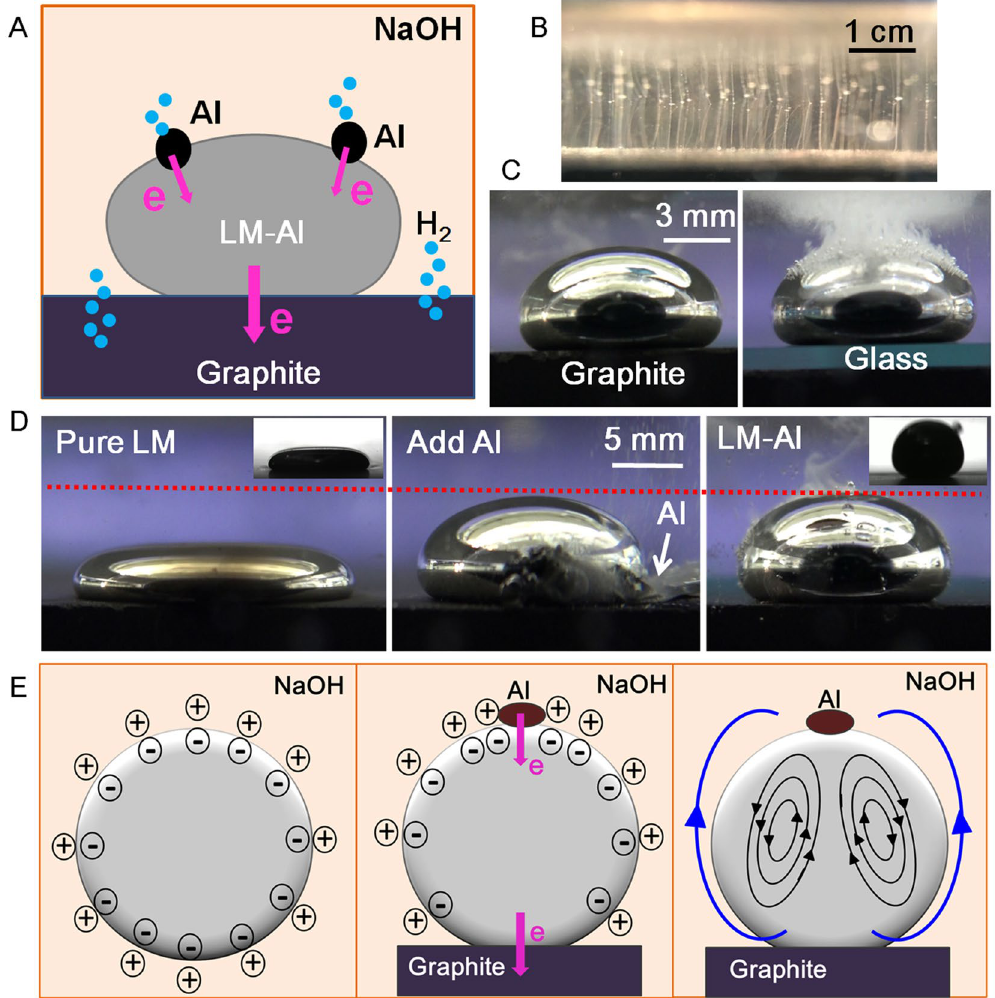
Figure 2. ( A ) Schematic diagram of the electrochemical interactions among Al, LM and graphite. ( B ) Hydrogen was bubbling from the gap of graphite surface. ( C ) Same LM droplet containing high Al in Case 3 on the graphite (left) and glass (right) substrate respectively. Abundant bubbles were observed on the LM-Al droplet on the glass substrate while few were observed on the graphite substrate. ( D ) Al reaction increased surface tension of LM droplet (500 uL) on graphite substrate. Inset: small drop (30–50 uL) of LM (left) and LM-Al (right) on graphite surface for the surface tension measurement. ( E ) The surface tension gradient on LM-Al droplet induced by the electrochemical interactions with Al and graphite. Left: The original surface charge distribution of LM droplet without Al in NaOH. Middle: The Al reaction and graphite interaction induced the surface charge imbalance across the LM-Al droplet. Right: Surface vortices were observed on the LM-Al droplet. The small black arrow rings here indicate the surface vortices directions and the two large blue arrows indicate the surface tension gradient from high to low across the